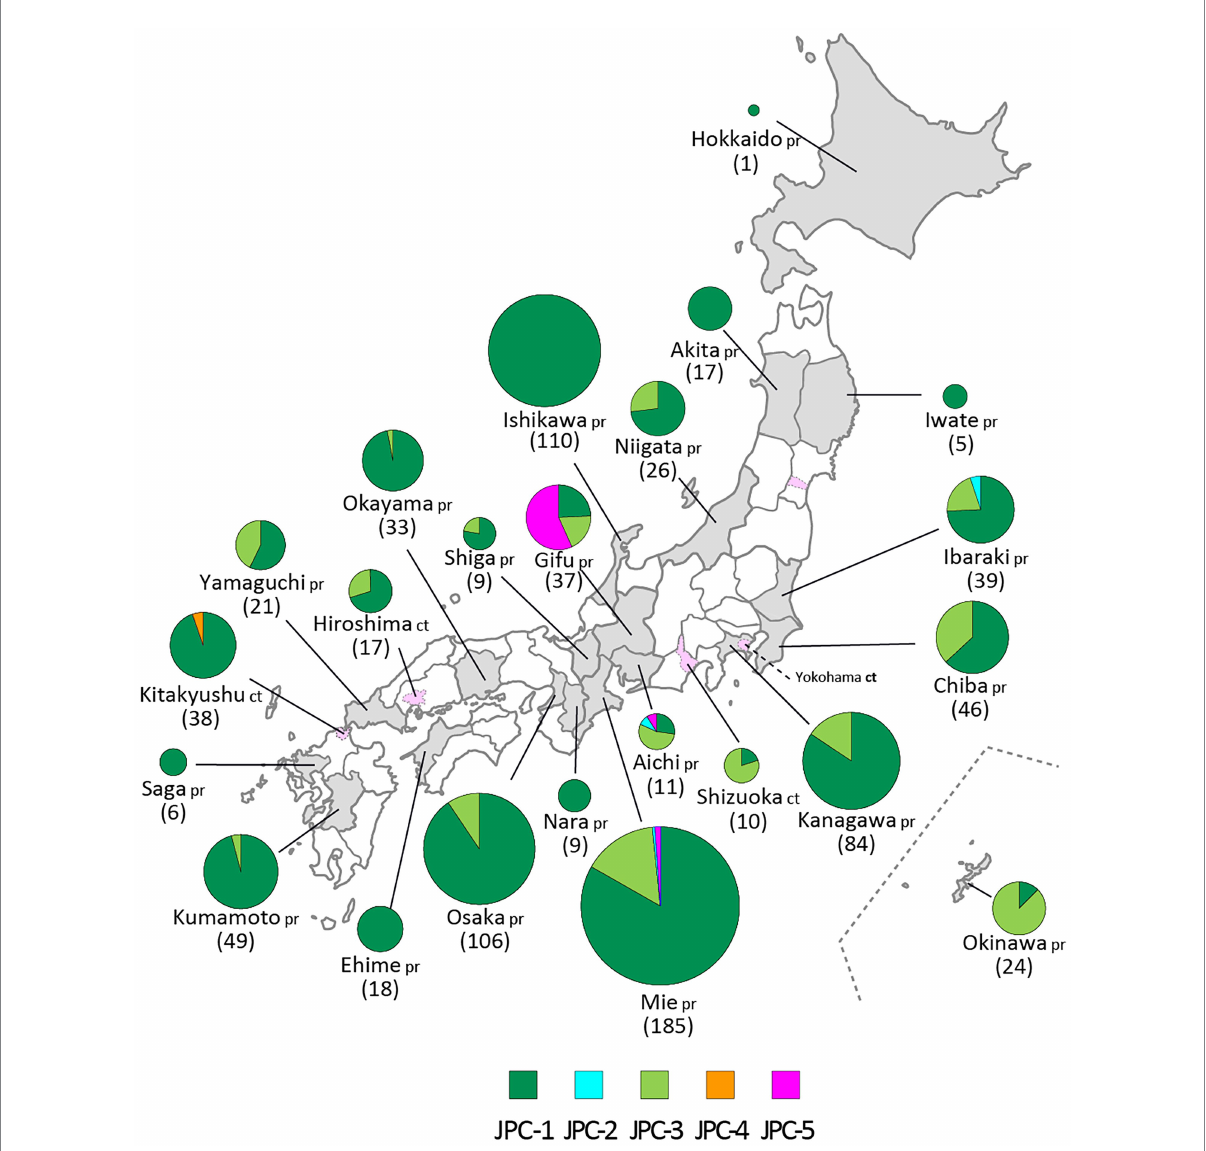
FIGURE 8 The geographic distributions of the Japanese clades of genotype G. The five clades of genotype G are color coded. The numbers in brackets refer to the total numbers of mumps viruses (MuVs) isolated from the prefectures (pr) or cities (ct). The administrative divisions where MuVs were isolated are color coded: grey-colored area for prefecture, pink-colored area surrounded by dashed line for